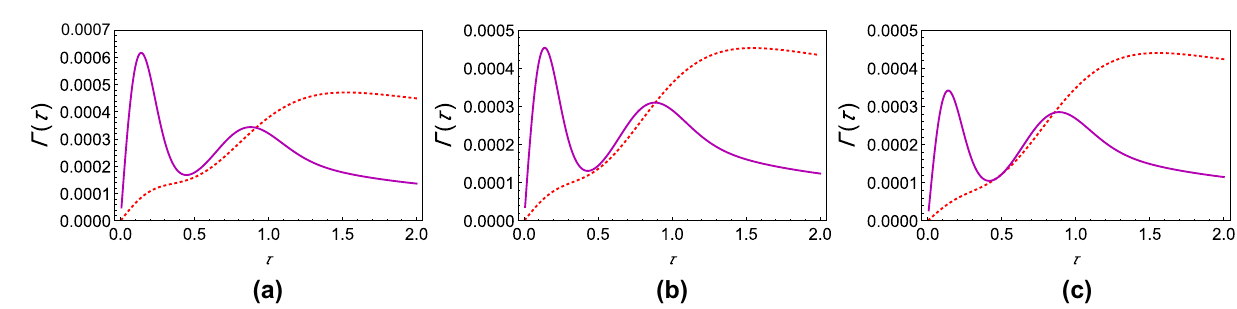
Figure 4. Transitory behavior in the effective decay rates. ( a ) Graph of Ŵ(τ) (at zero temperature) with the 1 (solid magenta curve) and G π/ 200 for G initial state corresponding to θ = = π/ 225 , showing critical behavior. ( c ) Same as ( a ) except Same as ( a ) with the initial state corresponding to θ c = π/ that θ =